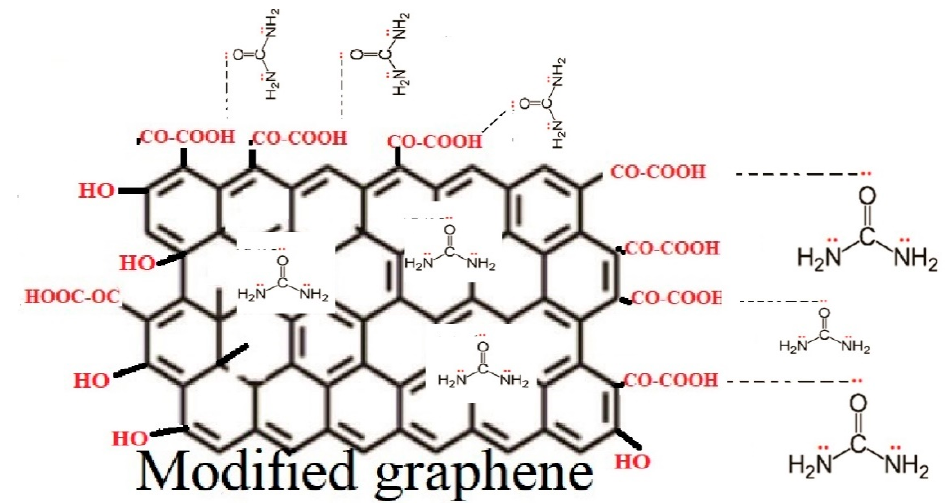
Figure 13. Proposal scheme for urea adsorption onto the modified graphene